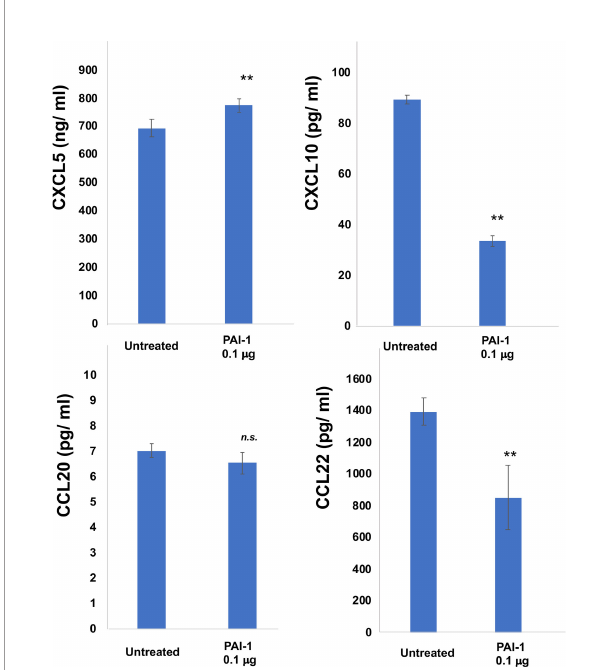
FIGURE 3 | Production of CXCL5, CXCL10, CCL20, and CCL22 by M2 macrophages treated with PAI-1. Culture supernatant from M2 macrophages was harvested as described in Materials and Methods and measured by ELISA (n=3). Data from each donor were obtained from triplicate assays, and mean ± SD values were calculated. Representative data from at least three independent experiments are shown. ** p < 0.01, Mann-Whitney U-test; n.s. , not signi fi